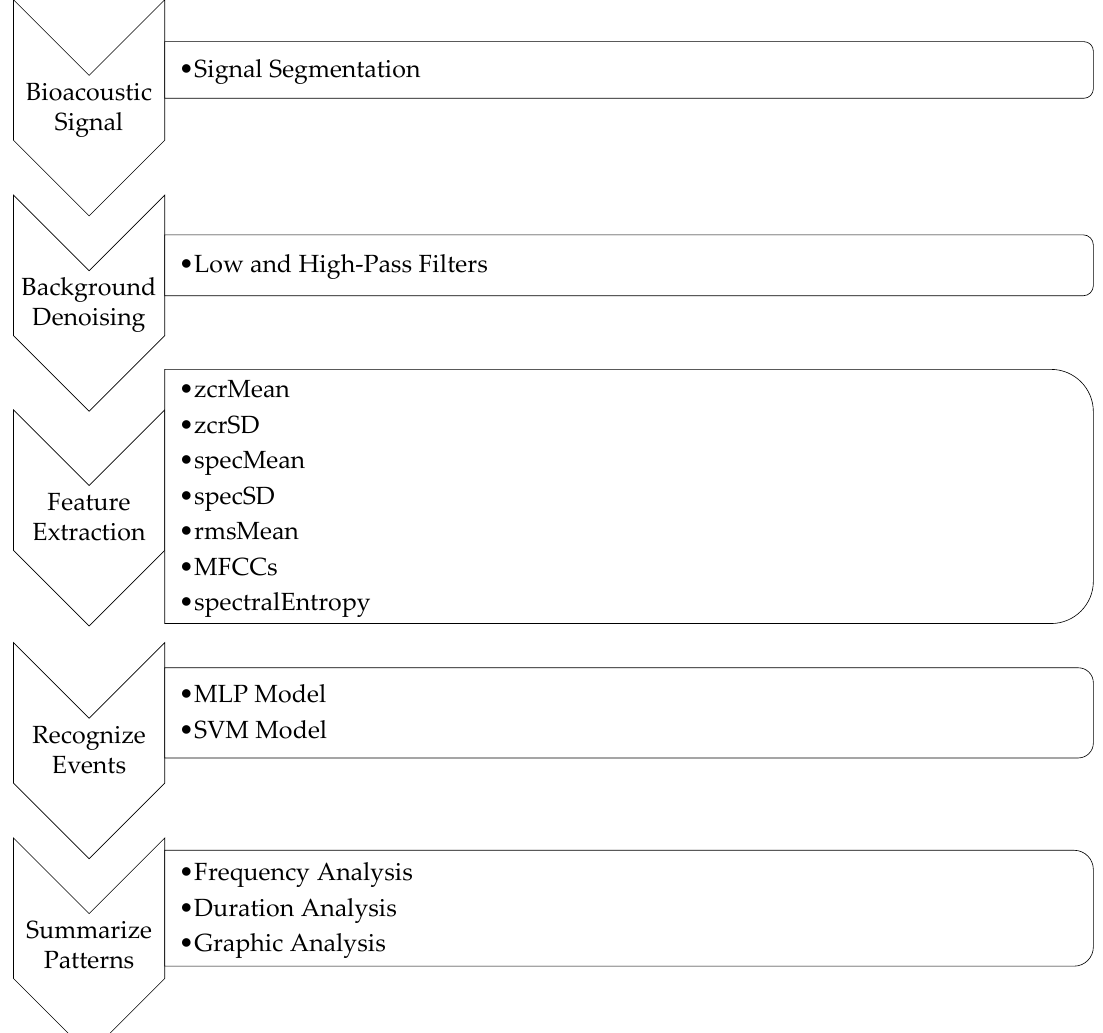
Figure 3. The FDG (frequency–duration graph) framework. The pattern summarization has been discussed using the FDG framework on three case studies.